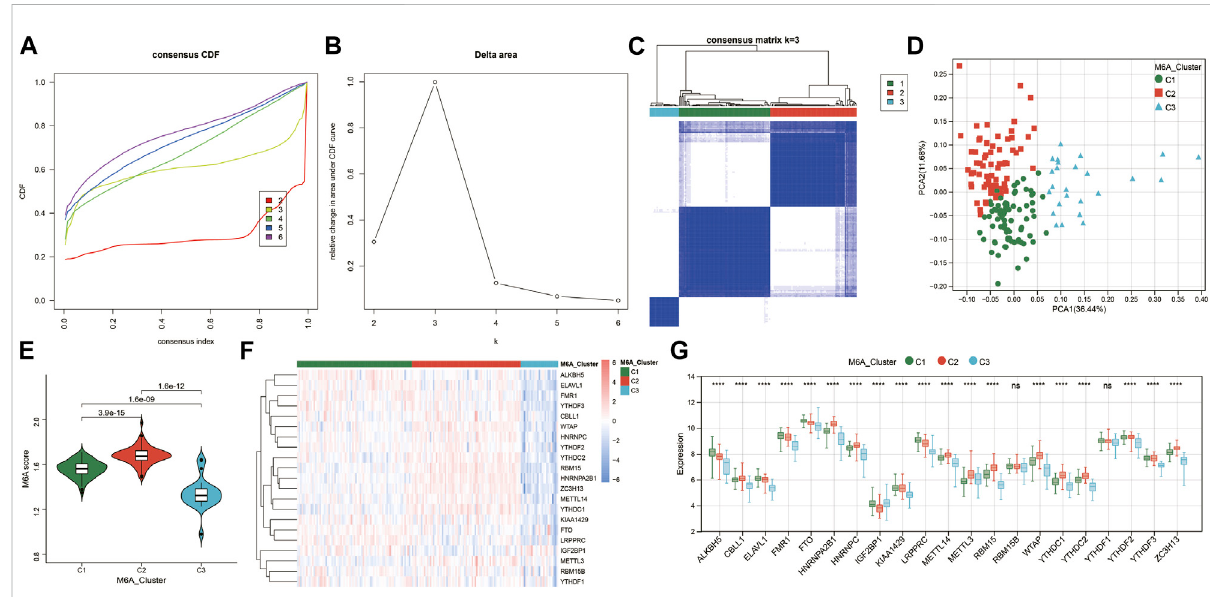
FIGURE 3 Identi fi cation of m6A-modi fi ed subtypes. (A) Consensus cluster cumulative distribution function (CDF) for k = 2 – 6. (B) Relative change in the area under the CDF curve at k = 2 – 6. (C) Consensus clustering matrix for optimal k = 3. (D) Principal component analysis (PCA) of the three m6A subtypes in renal fi brosis. (E) Violin plot of m6A score differences among the three m6A subtypes. (F) Heatmap of the m6A regulator expression among the three m6A subtypes. Red represents high expression and blue represents low expression. (G) The expression statuses of 21 m6A regulators in the three m6A subtypes. * means p less than 0.05; ** means p less than 0.01, *** means p less than